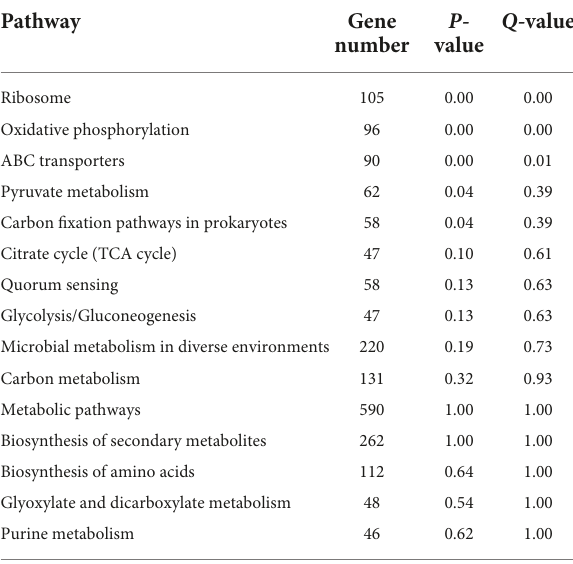
TABLE 1 The KEGG enrichment of the gene in black